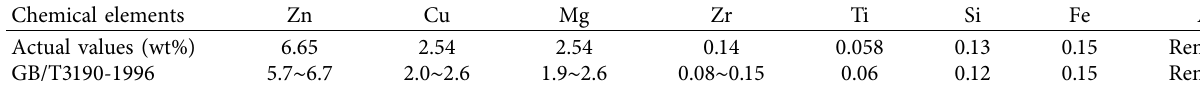
Table 2: The chemical composition of 7050 aluminium alloy (wt%).